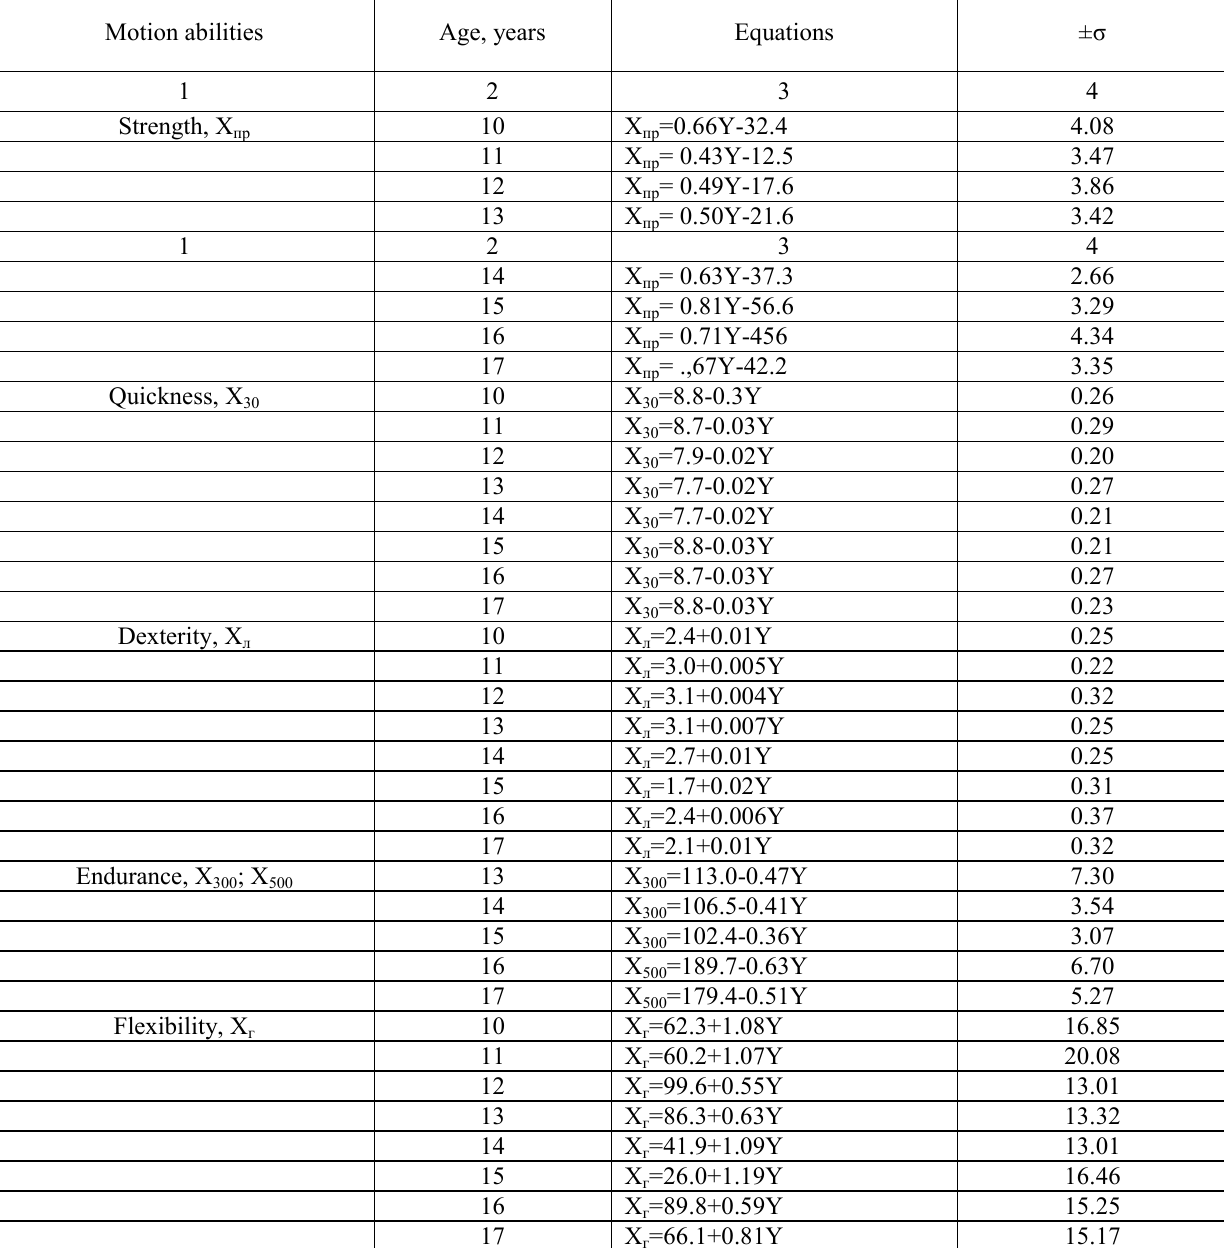
Regression equations for calculation of physical fitness models for 10-17 years old schoolgirls, required for passing of test – running high jump Motion